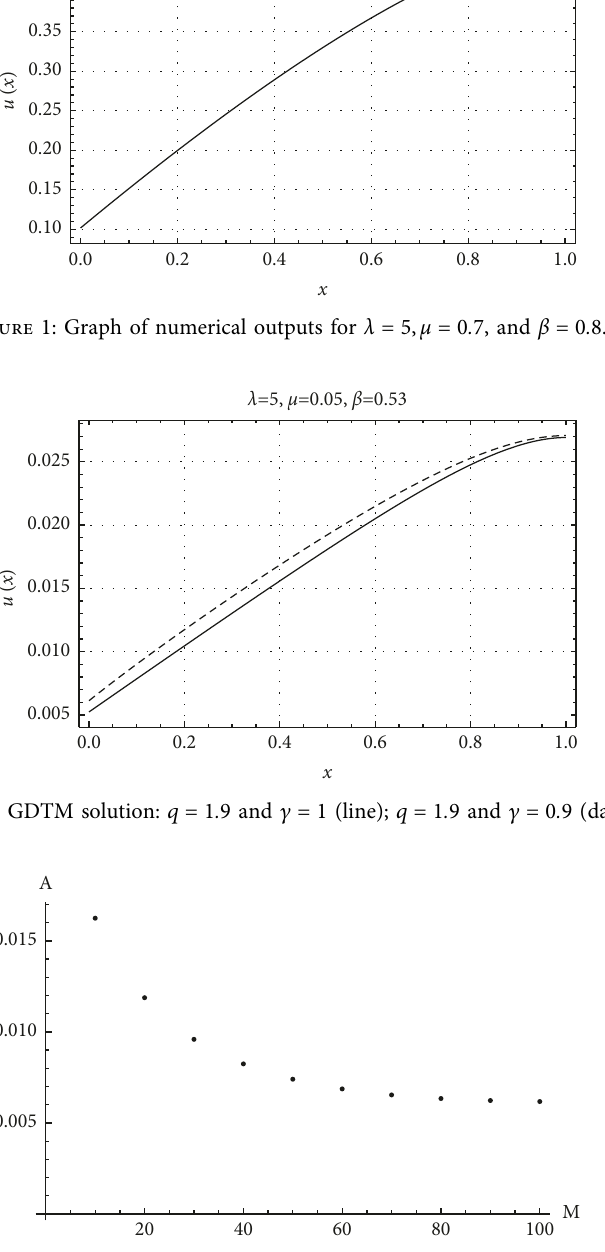
Figure 3: Variation of A with N for the case λ � 5 , μ � 0 . 05 , β � 0 .